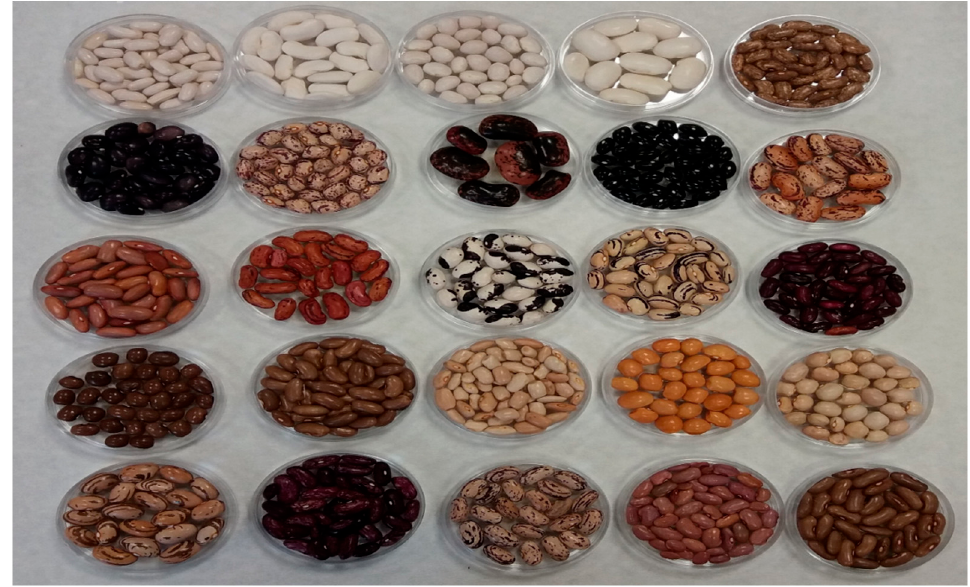
Figure 5. Seed color and shape diversity in Turkish common bean Figure 5 . Seed color and shape diversity in Turkish common bean germplasm.